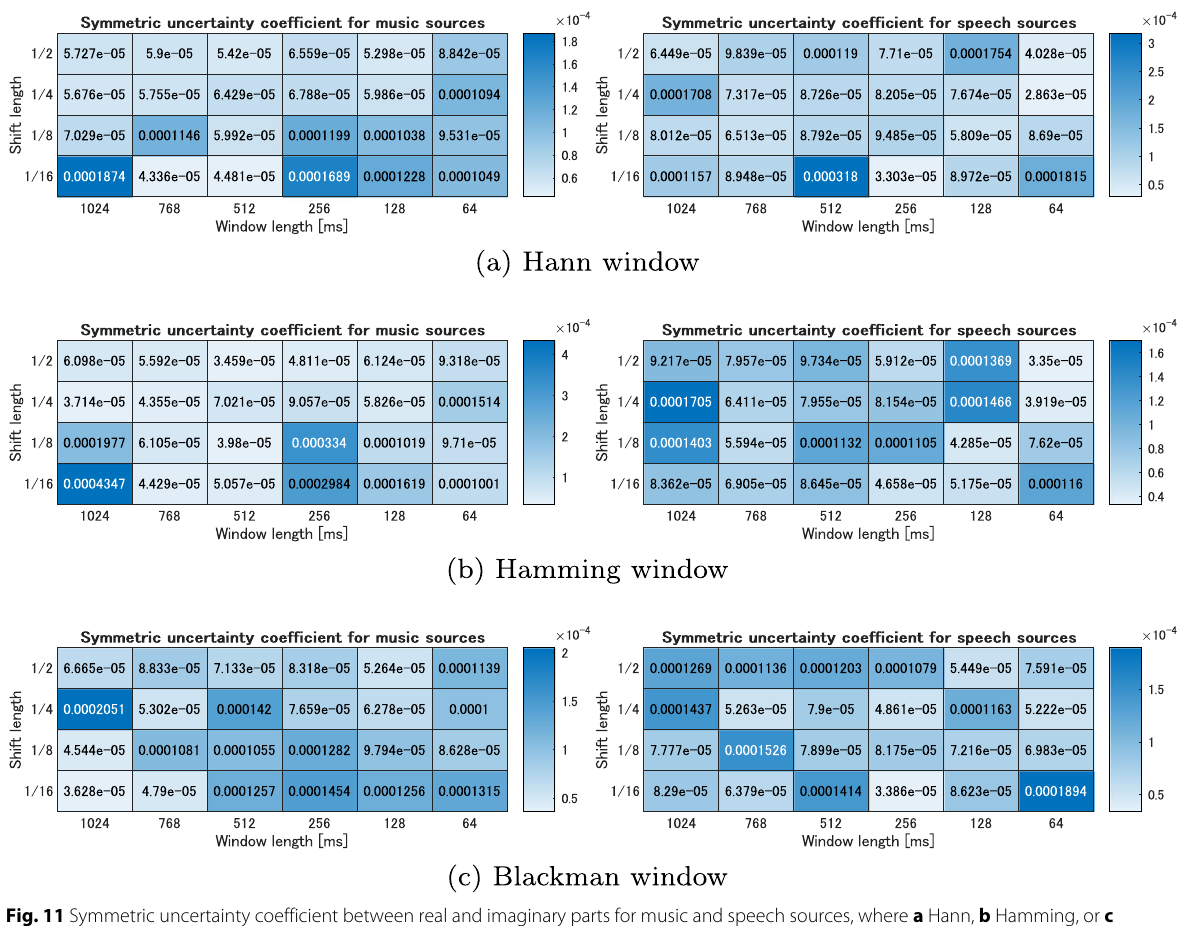
where Re ( · ) and Im ( · ) return the real and imaginary parts of an input complex value, respectively. Here, H ( Re ( s )) , H ( Im ( s )) , and H ( Re ( s ) , Im ( s )) were